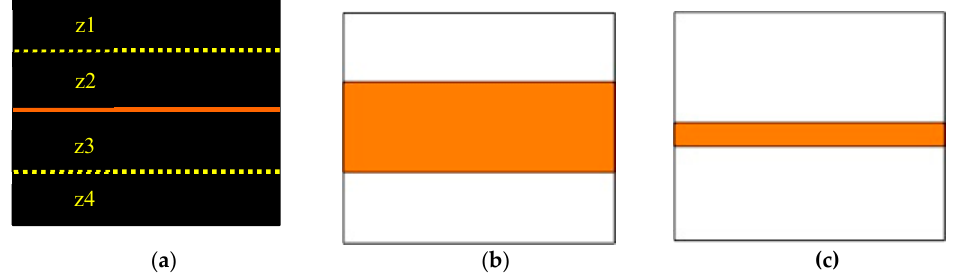
Figure 1. Schematic of the dartboard with target(s): ( a ) horizontal line target (solid orange) during pretest and Day 2’s tests of learning; zones z1–z4 are denoted in reference to the prediction tasks on Day 2, ( b ) large horizontal band target presented to the Large-target group, and ( c ) small horizontal band target presented to the Small-target group during acquisition.